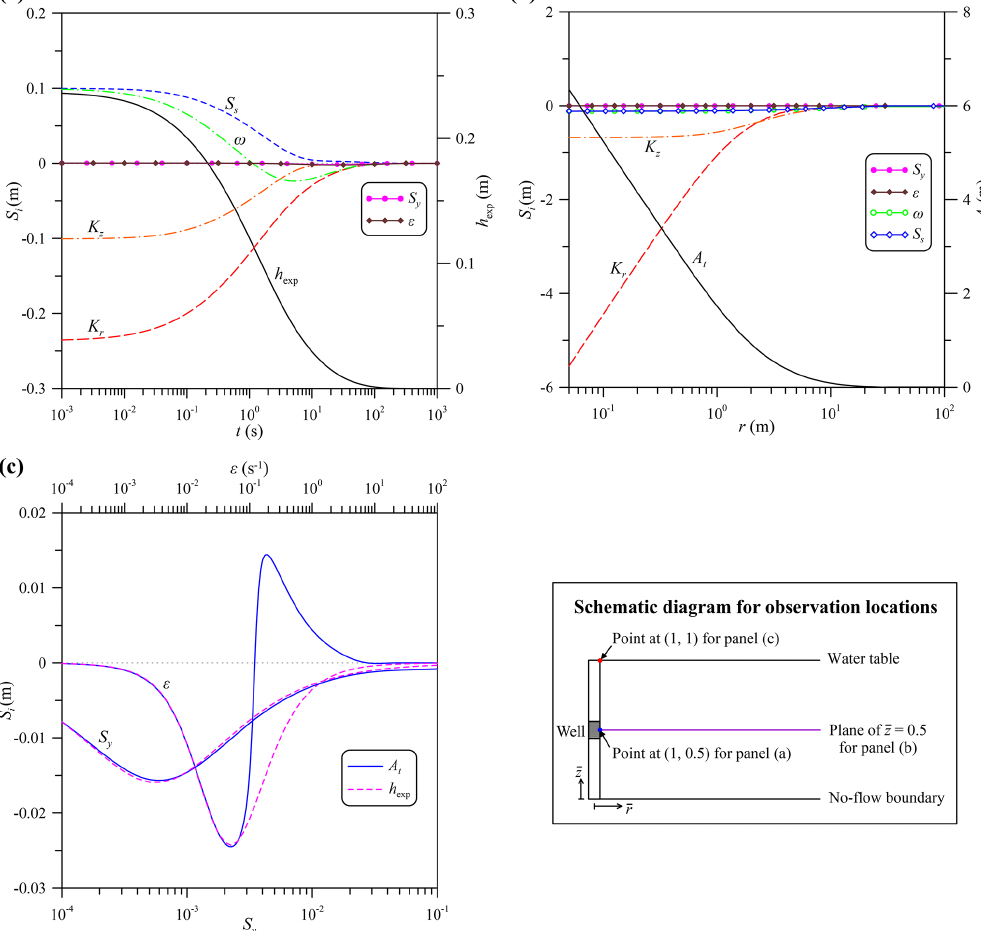
Figure 4. The normalized sensitivity coefficient S i associated with (a) the exponential component h exp of Solution 1 and (b) the SHM amplitude A t for parameters K r , K z , S s , S y , ω , and ε . The observation locations for (a) and (b) are under water table (i.e., z = 0 . 5); (c) displays the curves of S i of h exp and A t at water table (i.e., z = 1) versus S y and ε